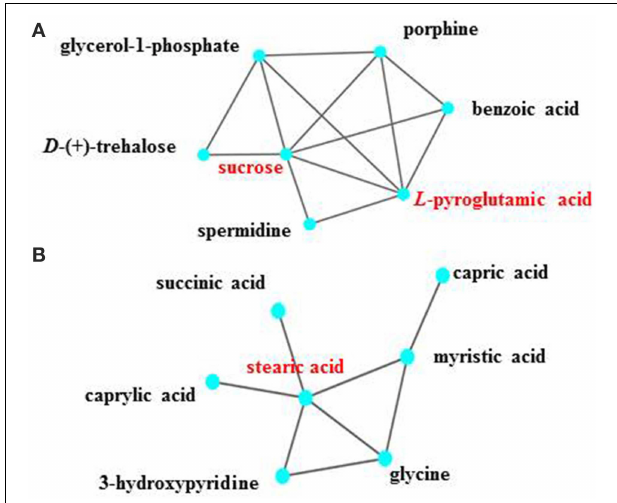
FIGURE 5 | The hub metabolites and their metabolic profiles as represented by the node and edge graph. (A) Sucrose and L -pyroglutamic acid in the module M4 at 24h; (B) Stearic acid in the module M6 at 48h.